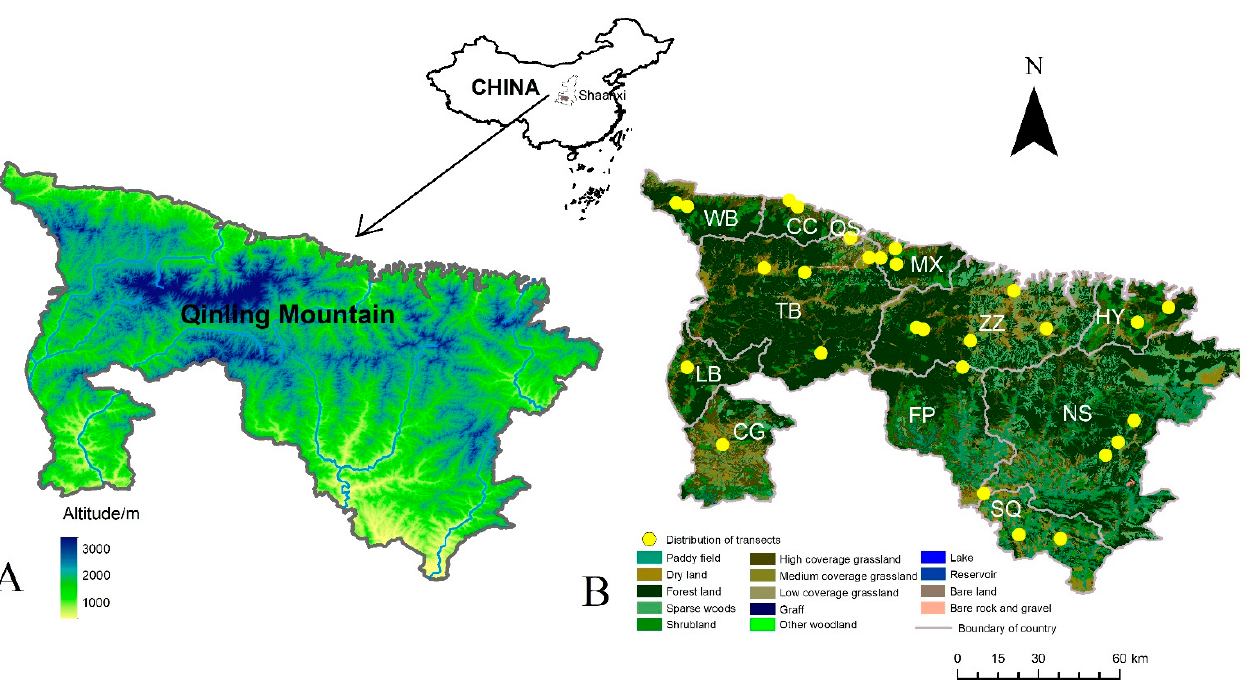
Figure 1. The geographical position and topological character ( A ) and habitat type map of the ecological study region of the middle Qinling Mountains ( B ). The counties on the right are Zhouzhi County (ZZ), Huyi District (HY), Meixian County (MX), Taibai County (TB), Qishan County (QS), Chencang District (CC) and Weibin District (WB), Liuba County (LB), Chenggu County (CG), Foping County (FP), Ningshan County (NS) and Shiquan County (SQ).